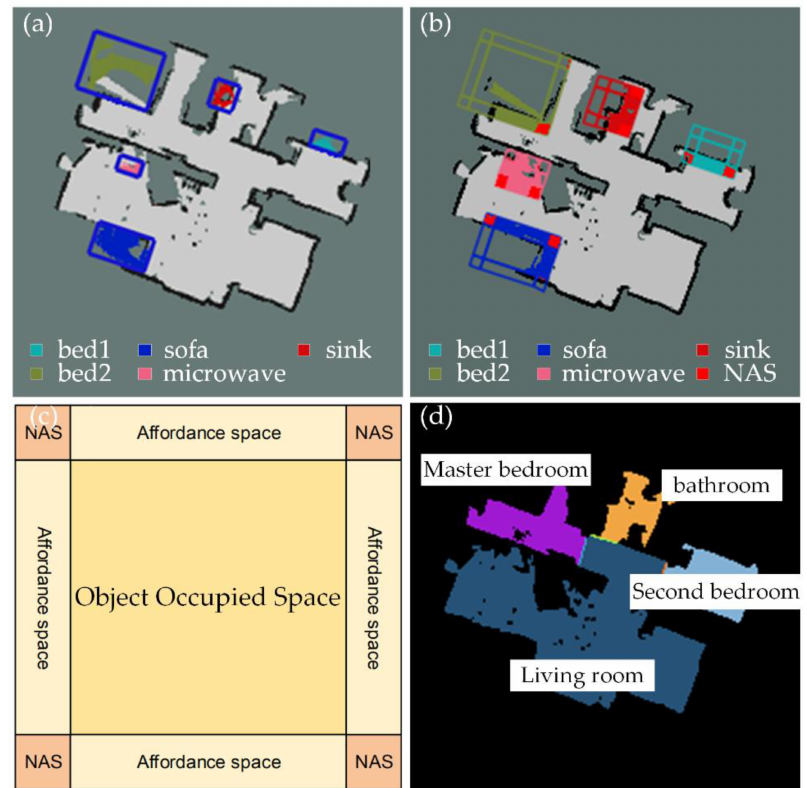
Figure 2. Object Semantic Grid and Topological Map. ( a ) Object semantic information and object occupied space. ( b ) Object goal space: red rectangle indicates the nona ff ordance space (NAS), and the original color rectangle indicates the a ff ordance space. ( c ) Spatial relationship of object goal space and object occupied space. ( d ) Semantic topological